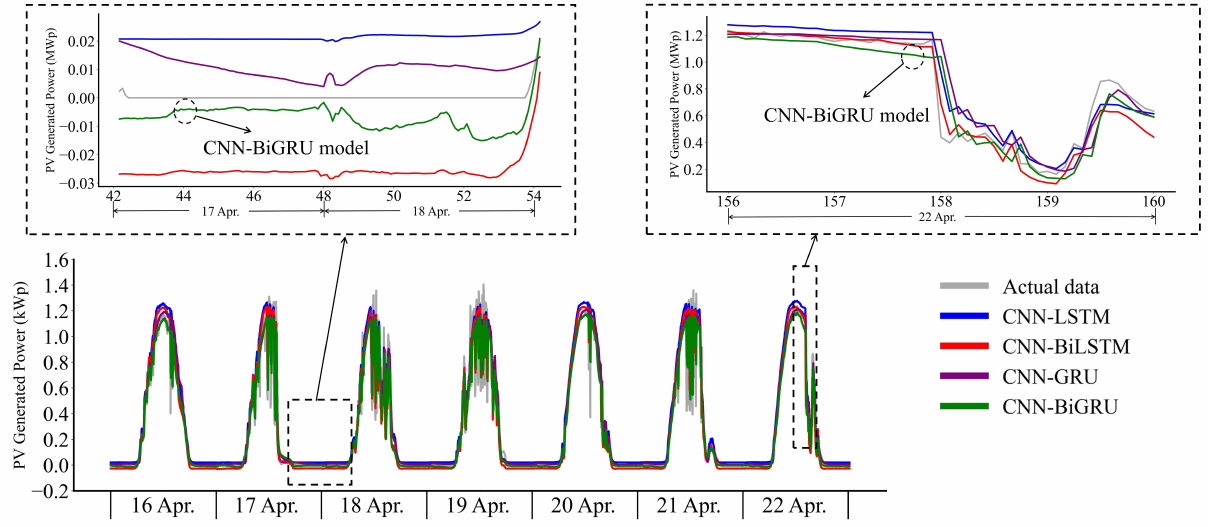
Figure 12. One-week PV generation forecasting obtained by a single model and compared with actual PV generation data. The left inset of the figure shows the forecasting performance of the hybrid model during constant PV generation, while the left inset figure illustrates the forecasting performance during highly fluctuated PV generation. In the single deep learning model, the most preferable model for short-term prediction of PV power generation on a cloudy weather day is BiLSTM model.